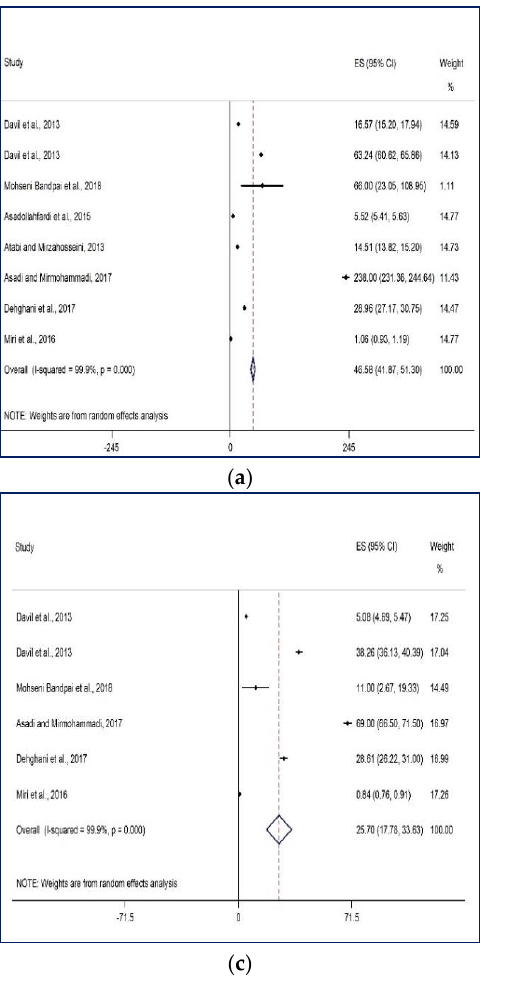
Figure 2. Forest plot of concentration (ppb) of benzene ( a ), toluene ( b ), ethylbenzene ( c ), and o-xylene ( d ) in the ambient air of Tehran. ES: effect size, CI: Confidence interval. Int. J. Environ. Res. Public Health 2018 , 15 , 1837